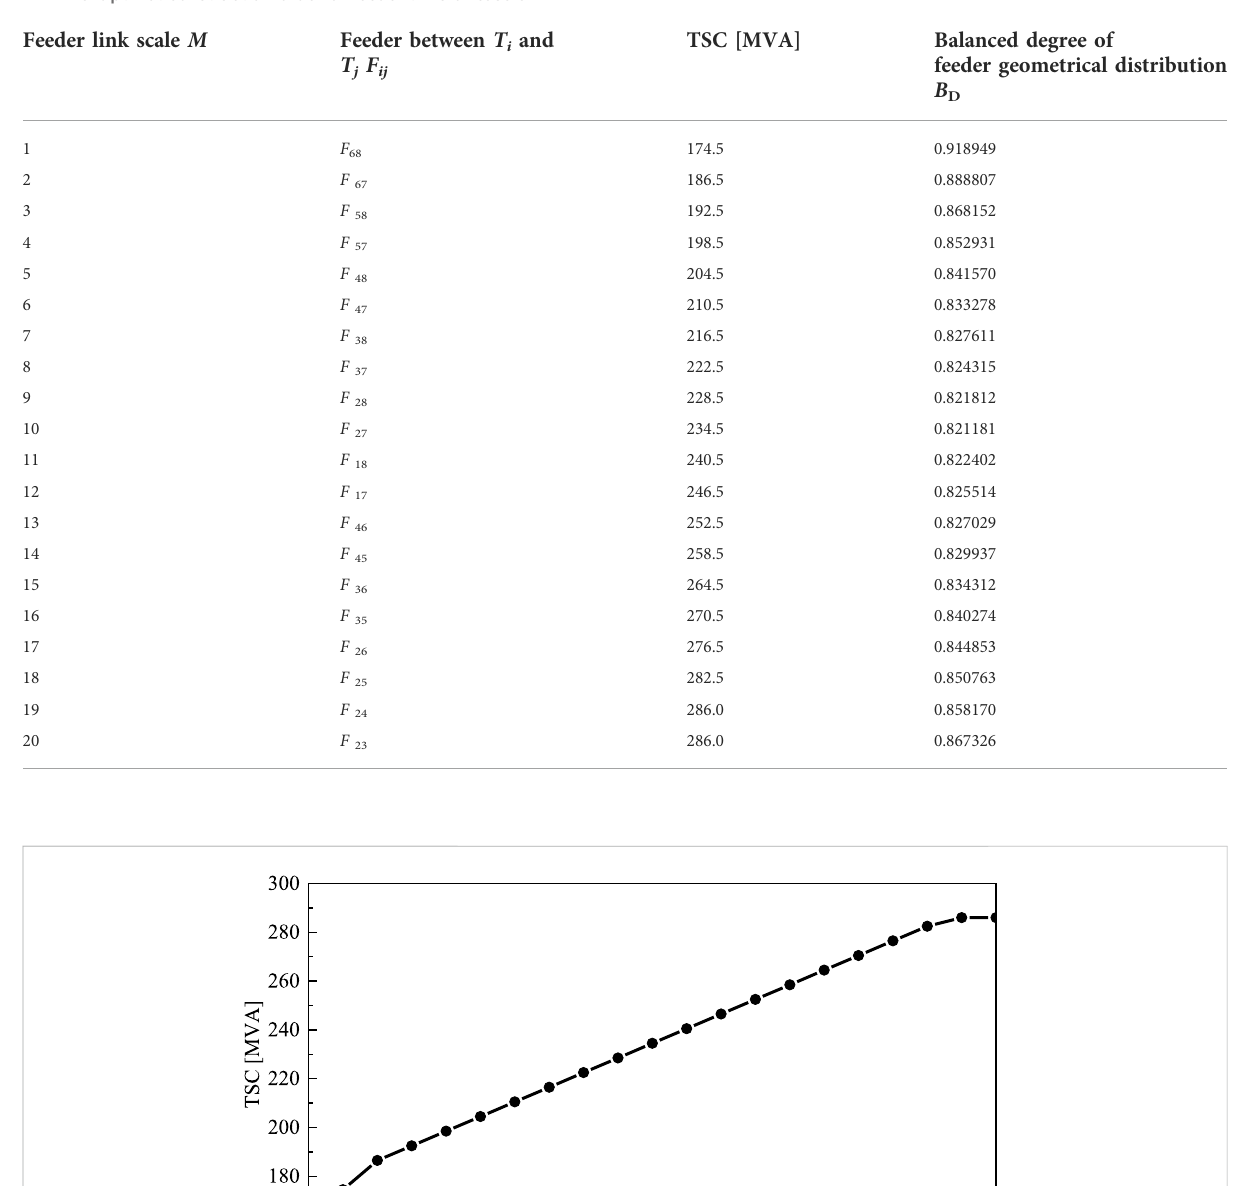
TABLE 3 Optimal construction order of feeder links of case 5.